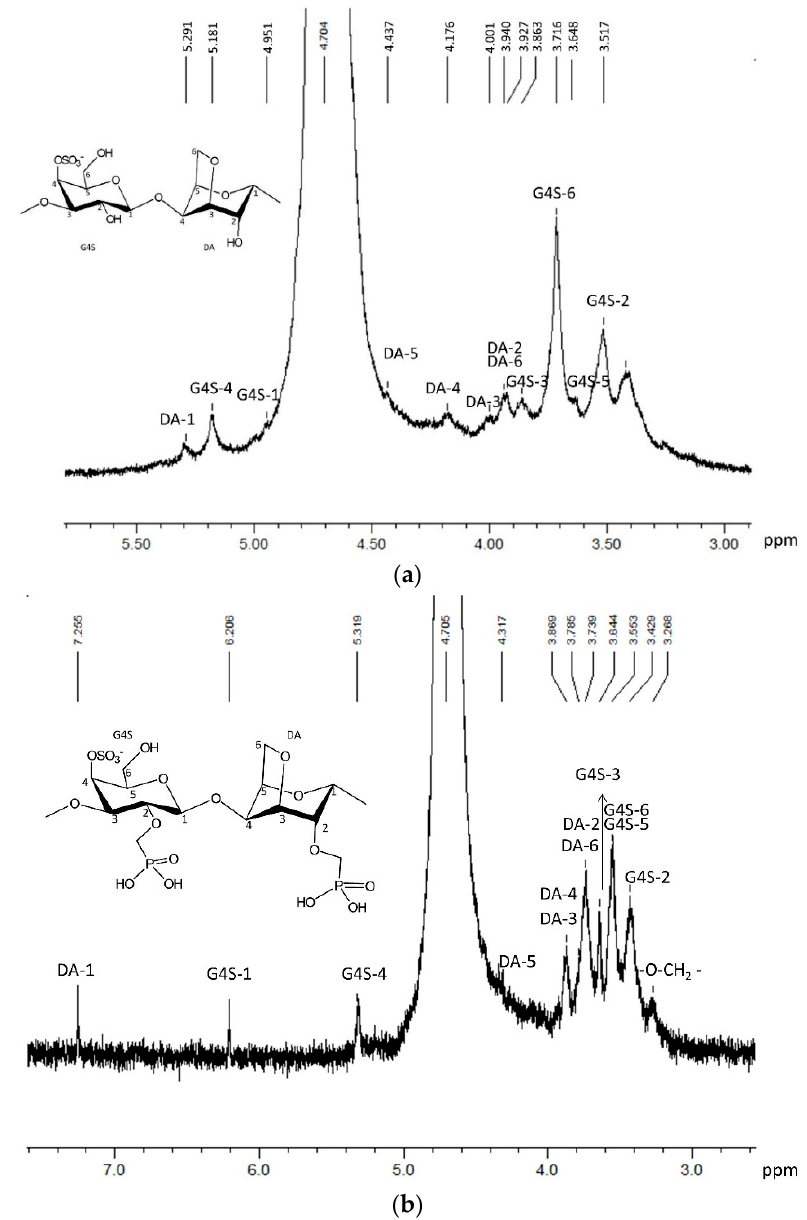
Figure 5. Nuclear magnetic resonance (NMR) spectra of the ( a ) κ -carrageenan and ( b ) O -methylene phosphonic κ -carrageenan (OMPk).